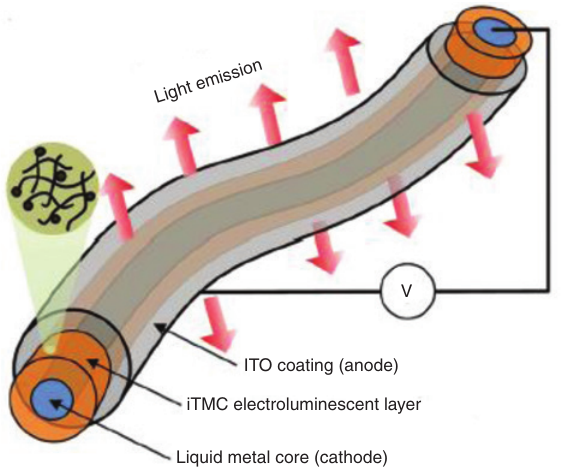
Figure 10: Schematic of a triaxial LEC fiber fabricated by coaxial ES and evaporation. PEO is used as a carrier polymer to allow ES of the + ( PF iTMC [Ru(bpy) ] ) − . (Reprinted with permission from Yang et al. 3 2 6 2 ACS Nano, 6, 622, © 2012 American Chemical